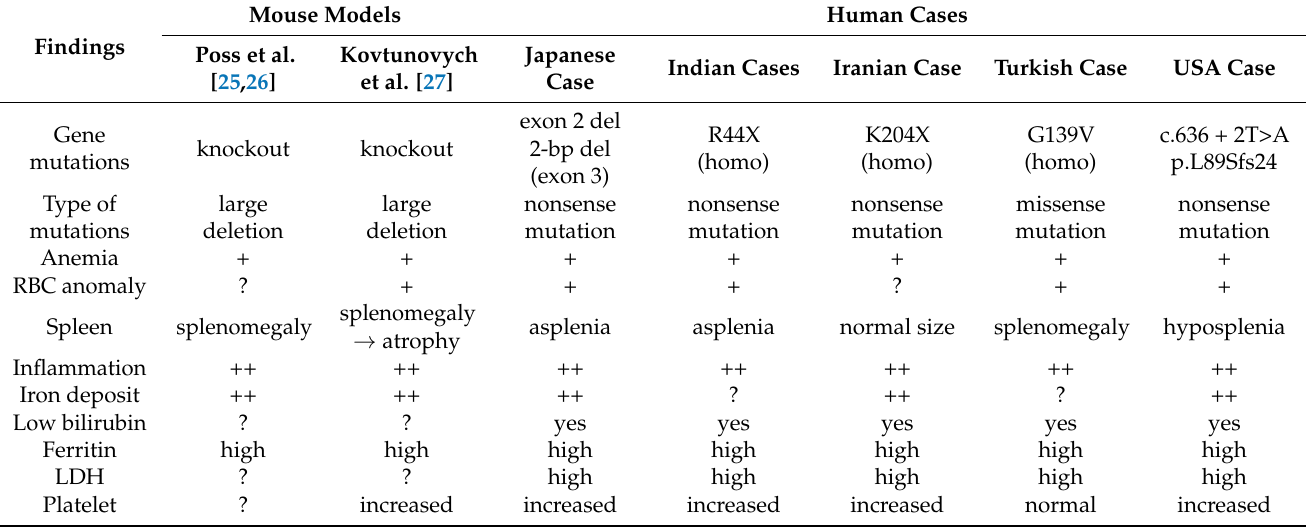
Table 3. Mouse models and human cases of HO-1